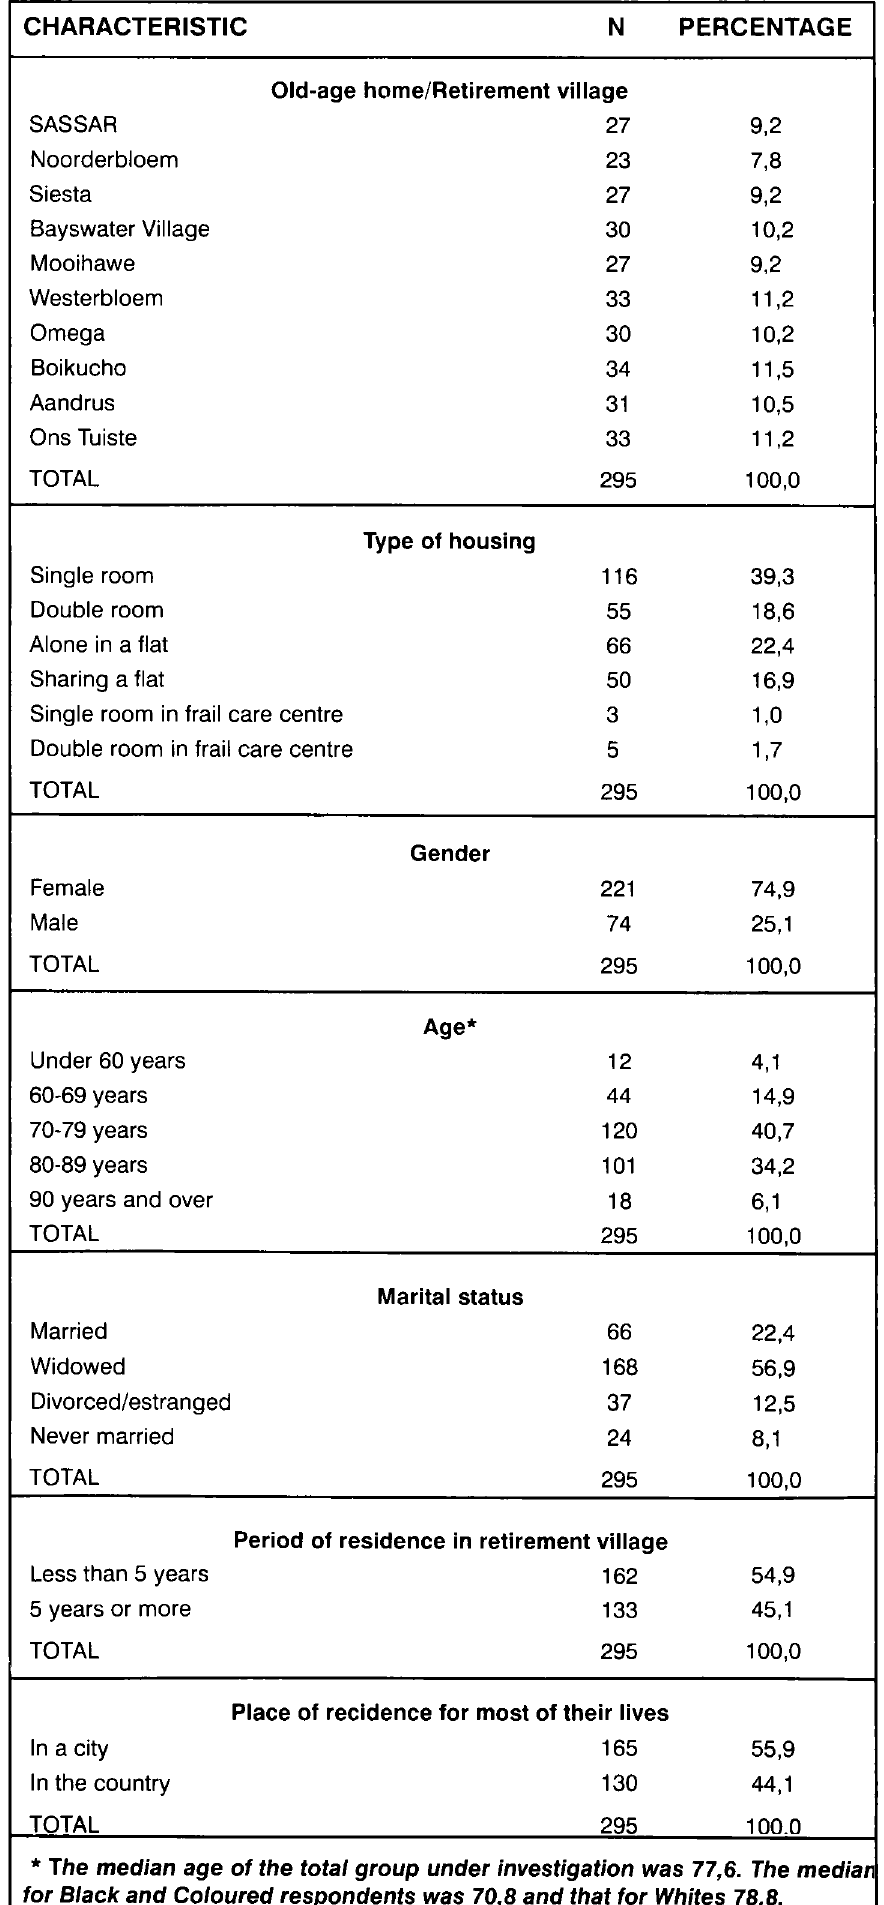
What did become clear from the investi­ gation is that at least 30% of the respond­ ents were not forced by circumstances to end up in an old-age